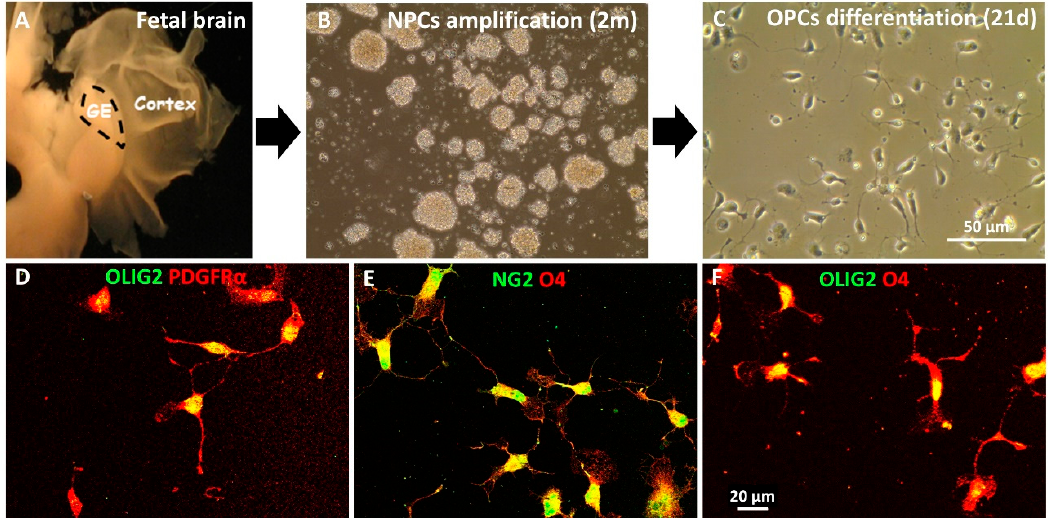
Figure 3. In vitro differentiation of hNPCs into hOPCs. ( A ) hNPC isolated from ganglionic eminence (GE) of the fetal brain were expanded as neurospheres in vitro for two months ( B ) before inducing them to differentiate into OPCs for 21 days ( C ). ( D – F ) Immunocytochemical characterization of the hOPCs illustrates their bipolar phenotype and expression of early stage oligodendroglial markers PDGFR α (red), NG2 (green) and O4 (red) in addition to OLIG2 (green).